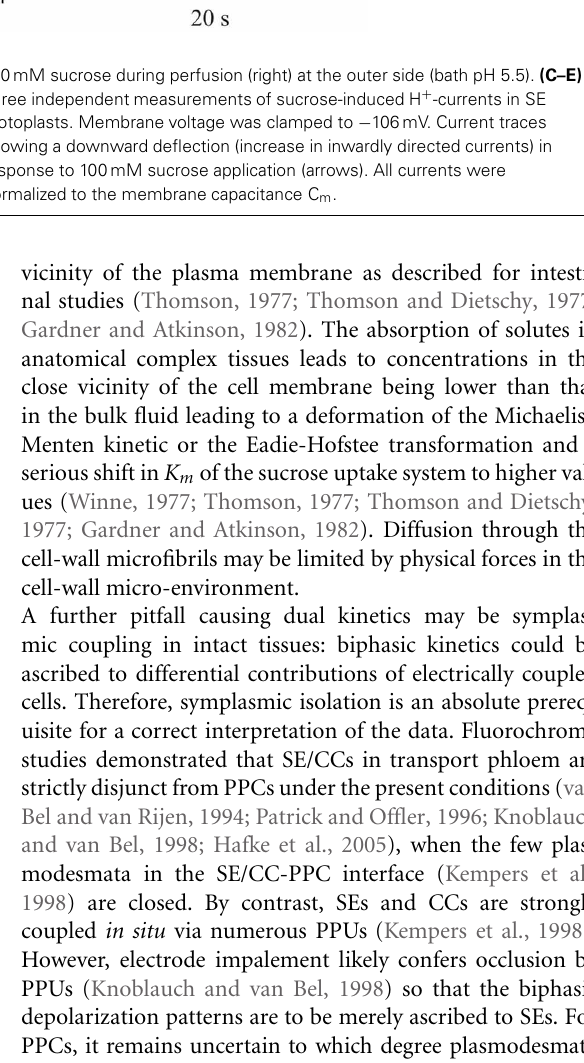
100mM sucrose during perfusion (right) at the outer side (bath pH 5.5). (C–E) Three independent measurements of sucrose-induced H + -currents in SE protoplasts. Membrane voltage was clamped to − 106mV. Current traces showing a downward deflection (increase in inwardly directed currents) in response to 100mM sucrose application (arrows). All currents were normalized to the membrane capacitance C m